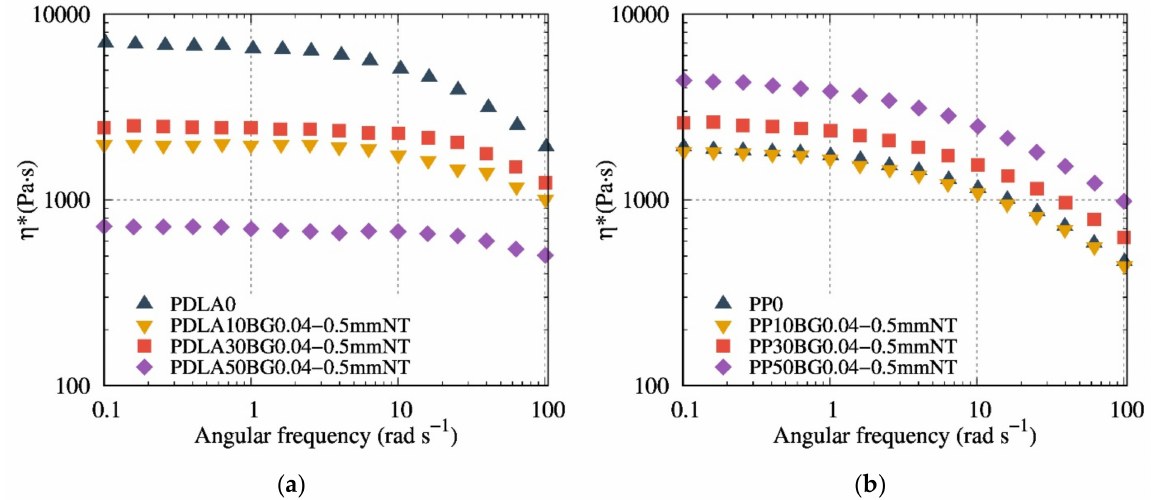
Figure 8. Evolution of the complex dynamic viscosity modulus versus the angular frequency ( a ) at 150 ◦ C for PDLA composites based on 0, 10, 30 and 50 wt% of 0.04–0.5 mm NT in comparison to ( b ) PP composites based on 0, 10, 30 and 50 wt% of 0.04–0.5 mm NT at 180 ◦